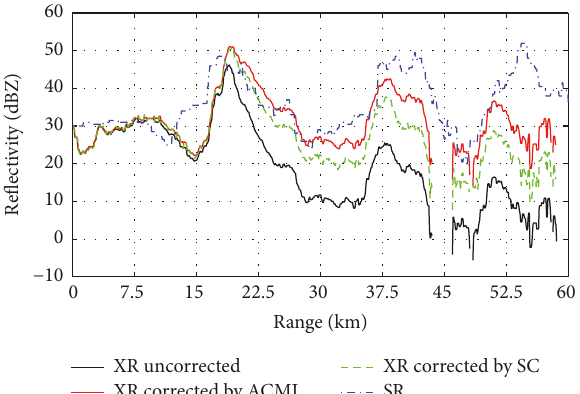
Figure 17: Range profiles of the SR reflectivity and XR reflectivity before and after correction along the ray of azimuth 237 ∘ in Figure